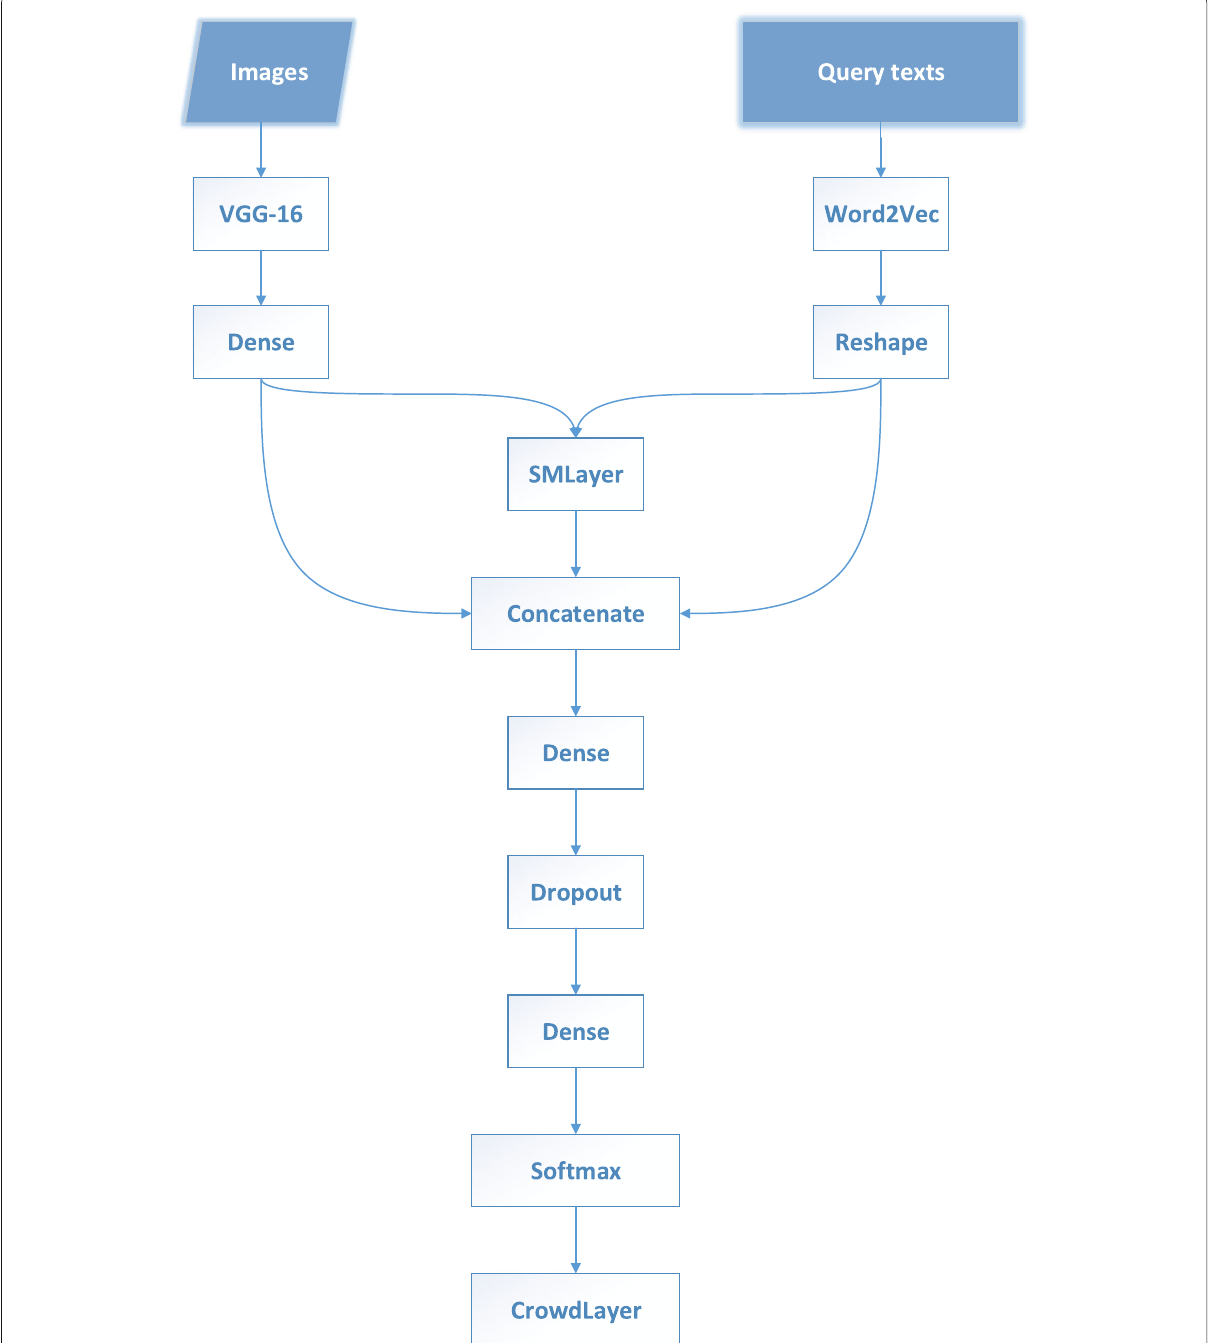
Fig. 5 Genaral structure. Structure of our proposed network for relevance evaluation using deep learning, which contains a crowd layer at the top of softmax